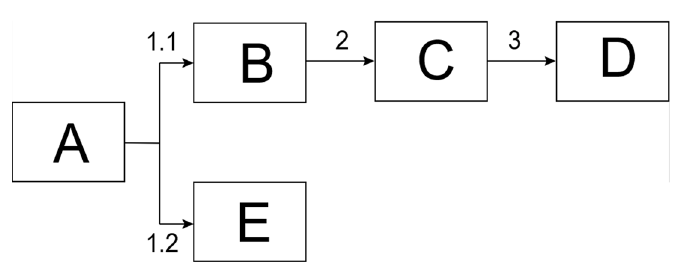
Figure 11. Activation energies calculated using Friedman analysis (black) and the Ozawa − Flynn − Wall method (magenta) under 2% oxygen.